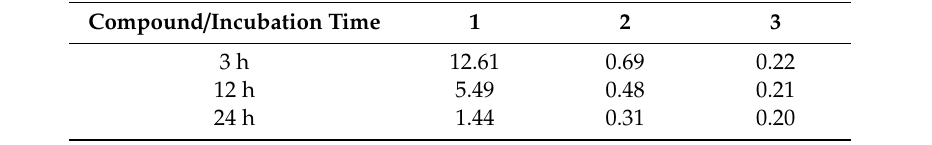
Table 2. IC 50 values ( µ M) of PS 1 , GO–PS 2 , and GO–PS 3 at 3 h, 12 h, and 24 h incubation times after photoirradiation.